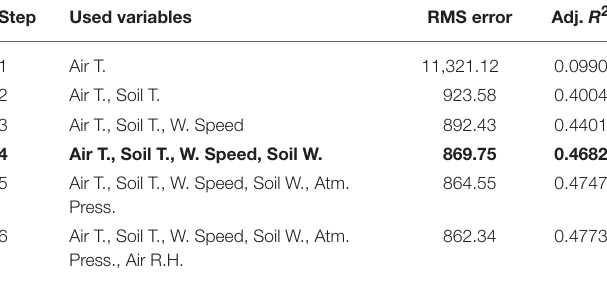
Frontiers in Earth Science |